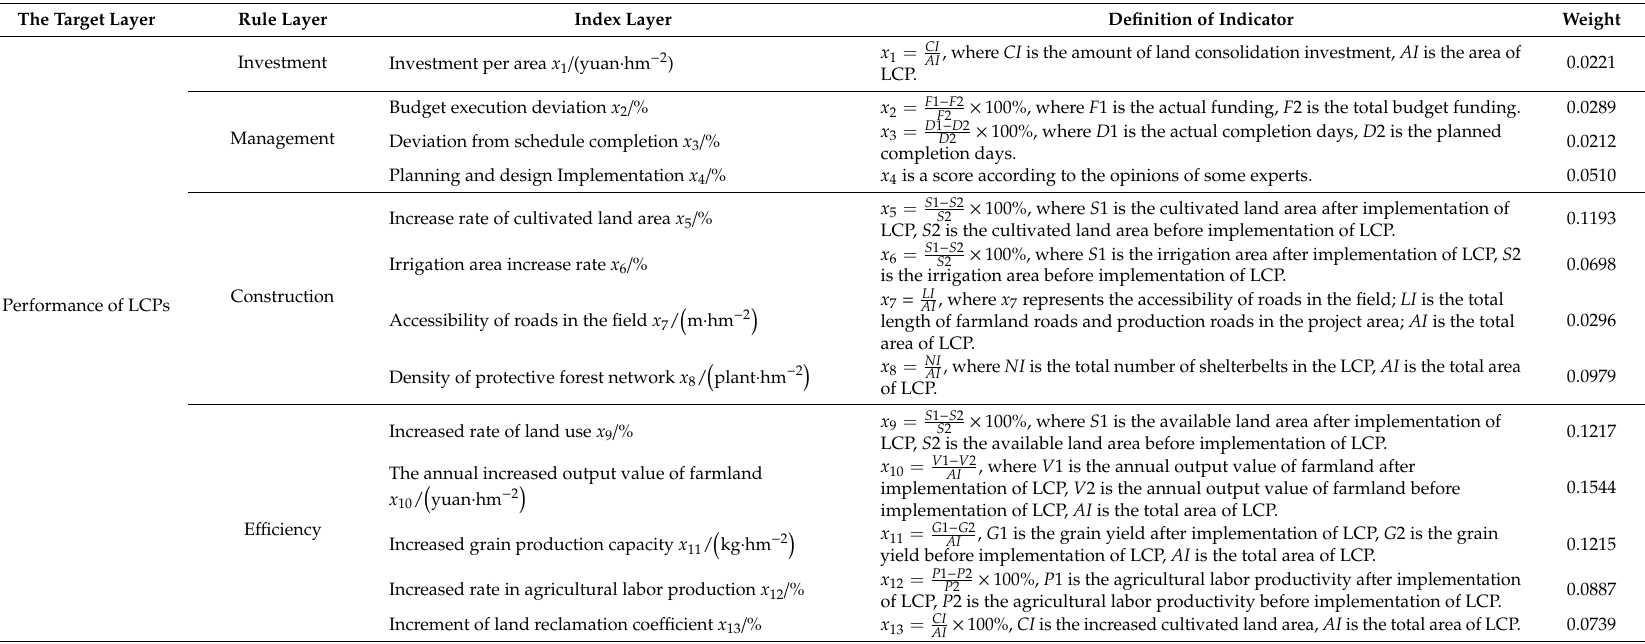
Table 1. The performance evaluation index system of land consolidation projects and its